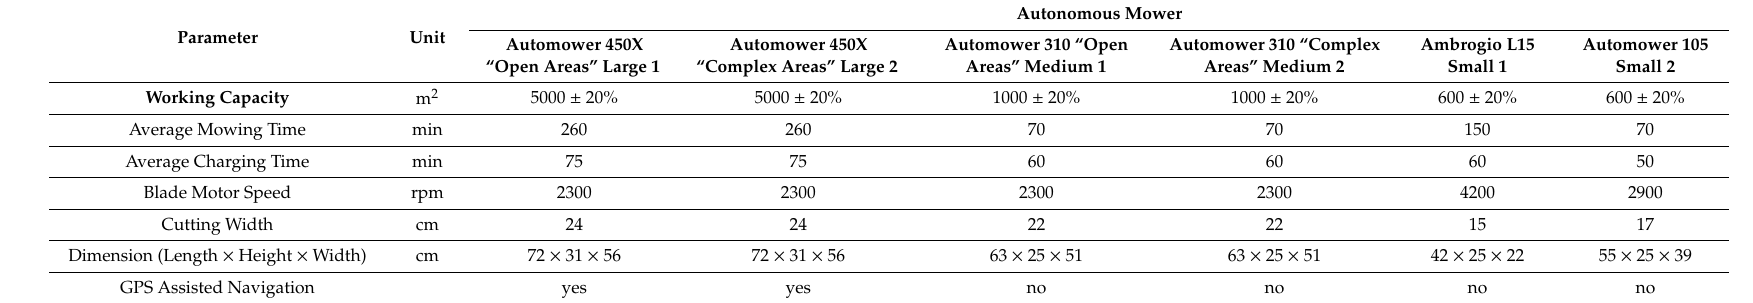
Table 1. Main features of the six autonomous mowers studied in the